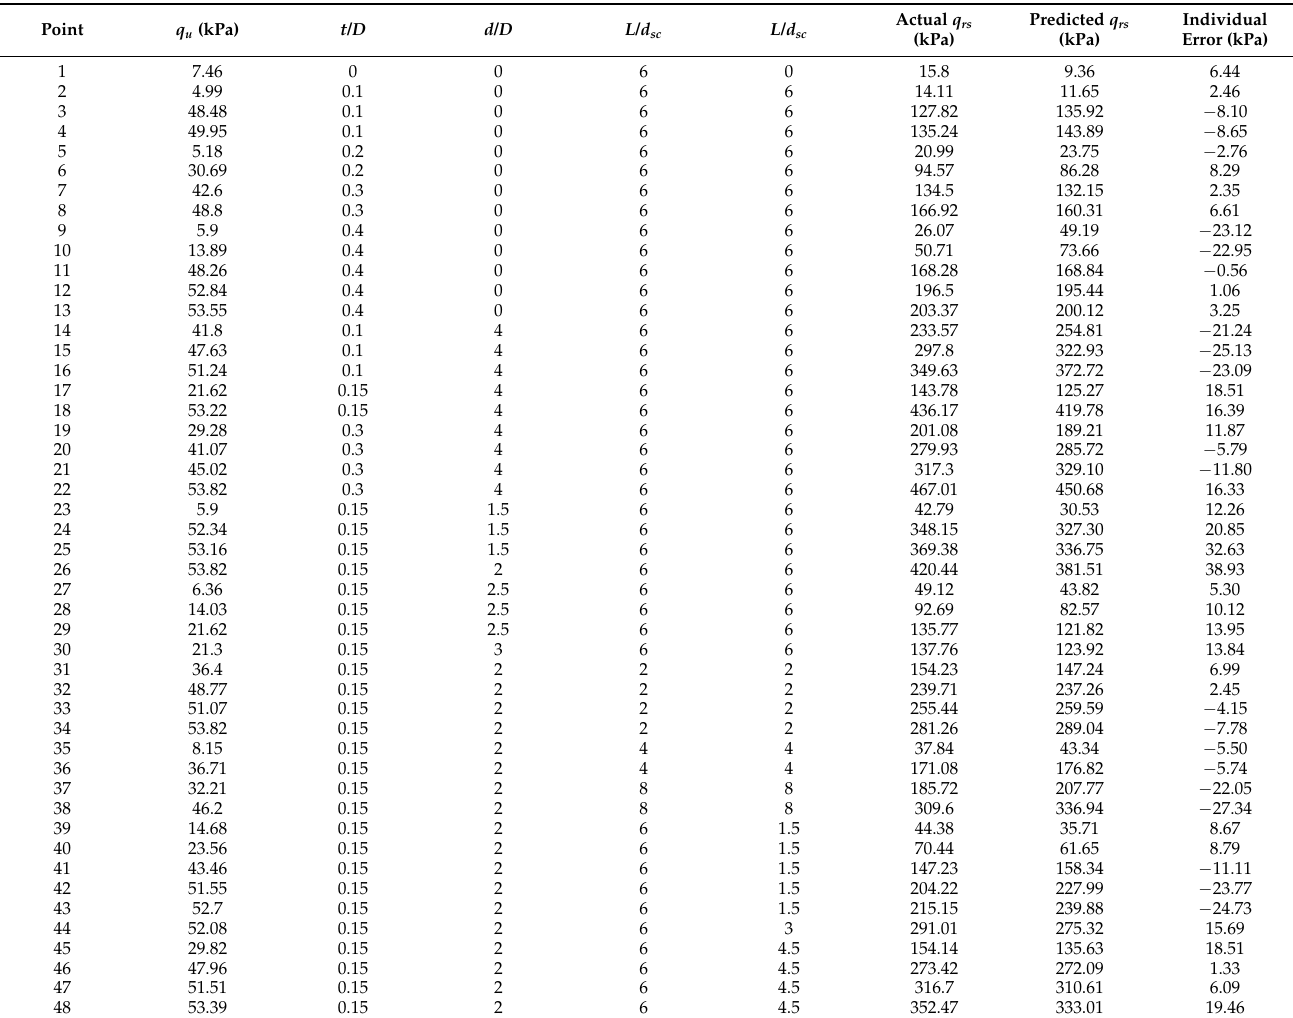
Table 4. Evaluating the performance of the MPR model vs. prior black-box models for predicting the bearing capacity.